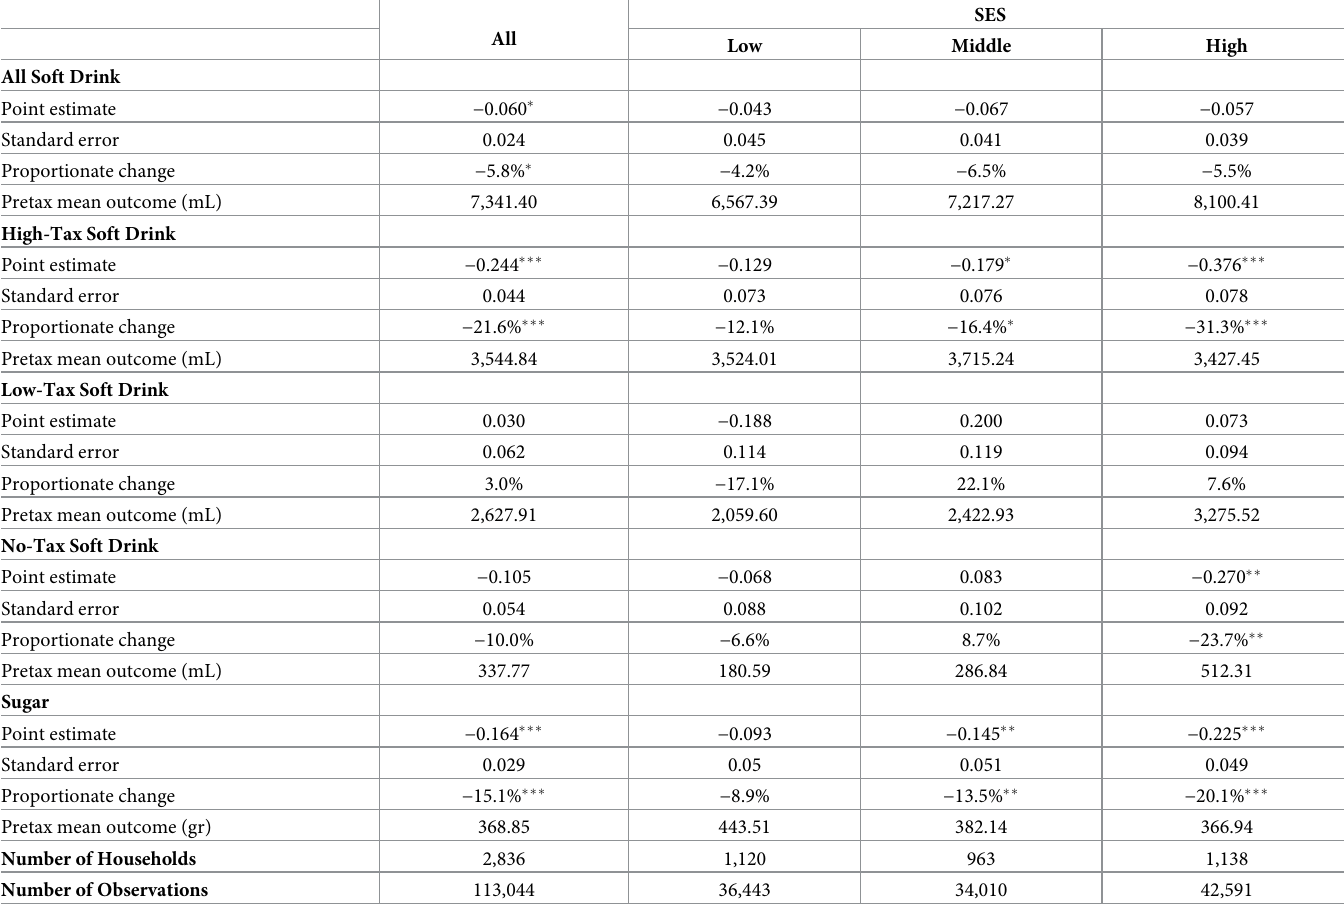
Table 2. Results from fixed-effects volume regression model (outcome in log